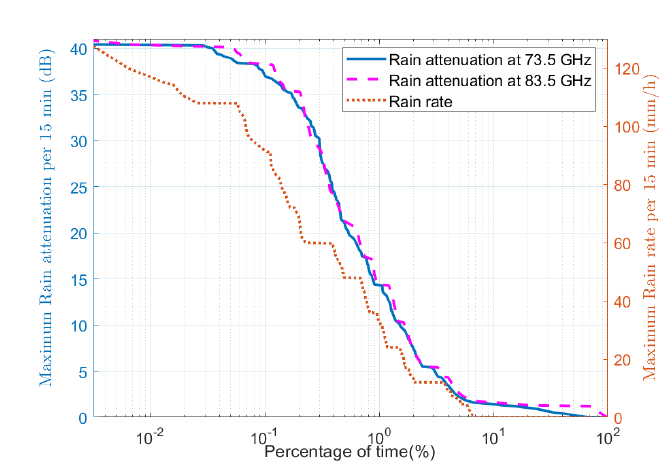
Figure 3. Cumulative distribution for maximum rain attenuation along 1.8-km LOS links.